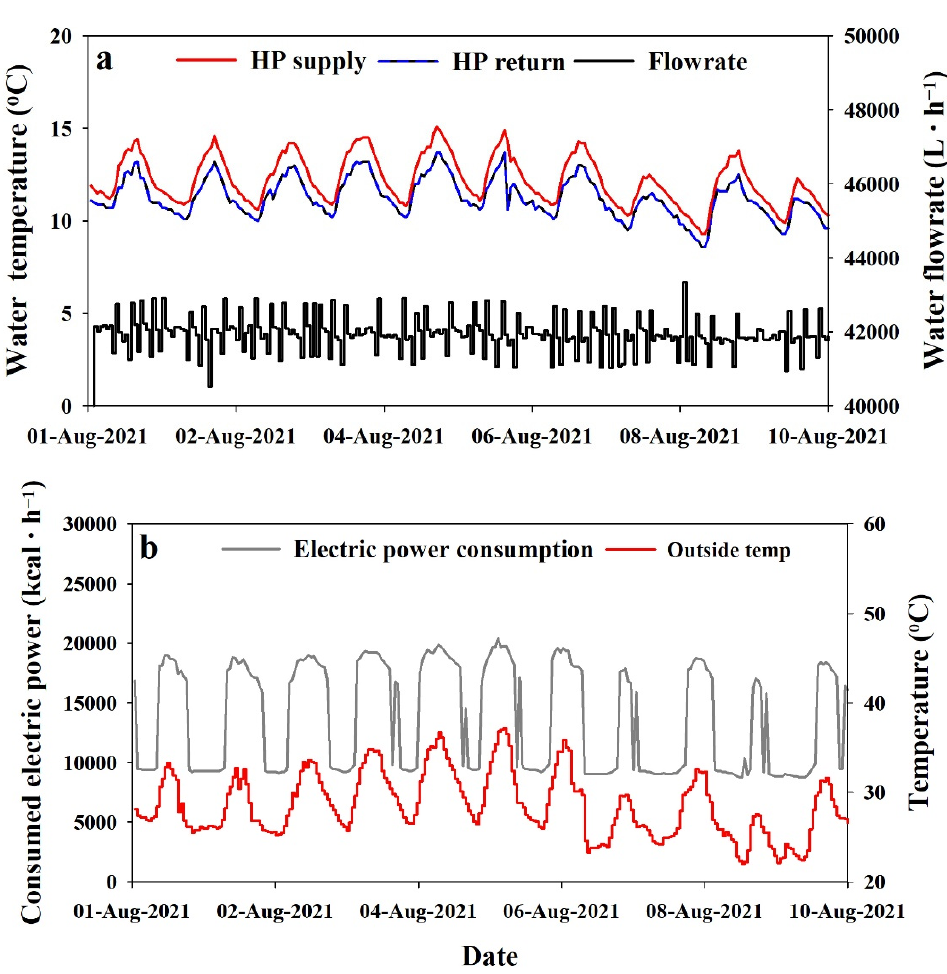
Figure 15. Analysis of heat pump input and output on cooling mode ( a ) water temperature and flow rate ( b ) power consumption.